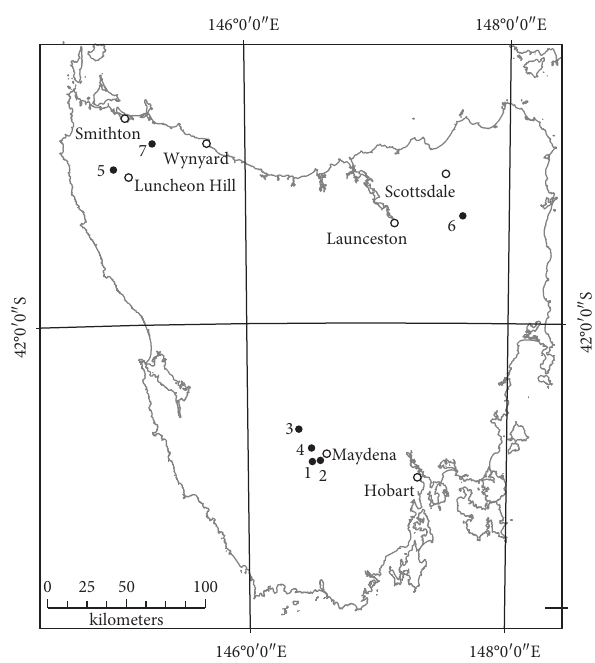
Figure 2: Site locations. For site names, see Table